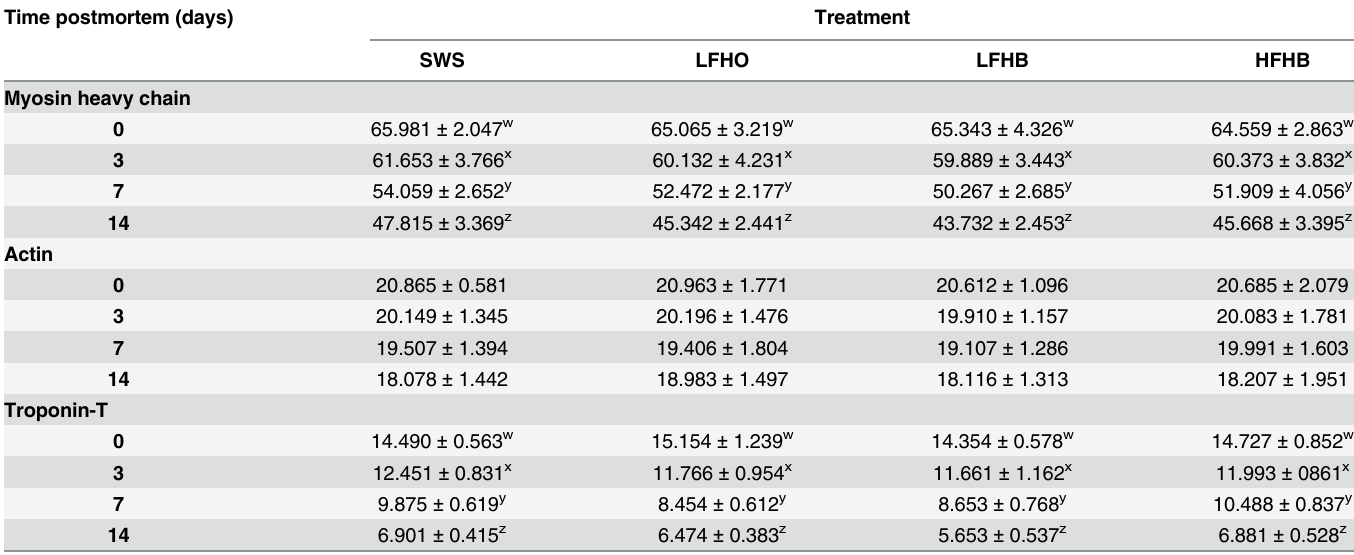
Table 4. Reflective density/mm 2 of myosin heavy chain, actin and troponin-T of longissimus lumborum muscle during postmortem aging periods in goats subjected to slaughter without stunning and slaughter following different methods of electrical stunning (mean ± SE, n = 8). Time postmortem